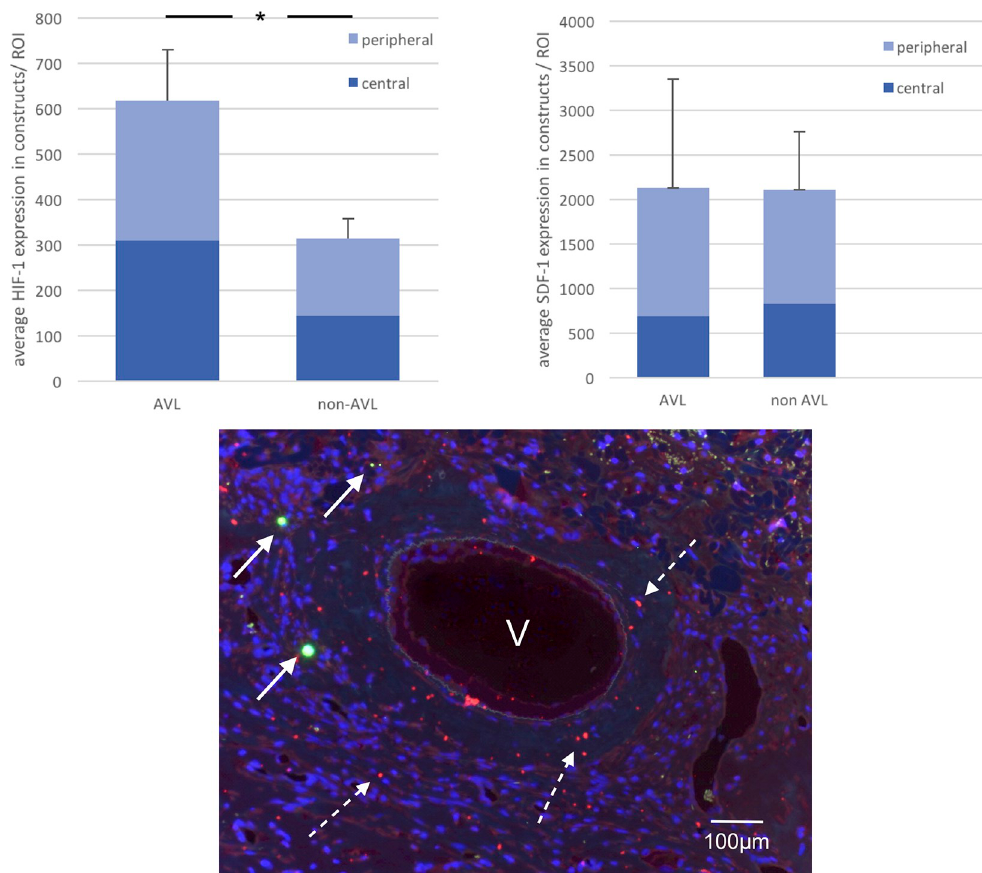
Fig 5. Above: histomorphometric analysis of HIF-1 and SDF-1 expression within the constructs, ( � ) indicates statistical significance. Below: combined Immunofluorescence image of AVL construct showing the vascular axis (v), the homing cells labelled with QDots in green (arrows), the SDF-1 expression in red around the vessel (dotted arrows) and the cell nuclei in blue stained with Hoechst.